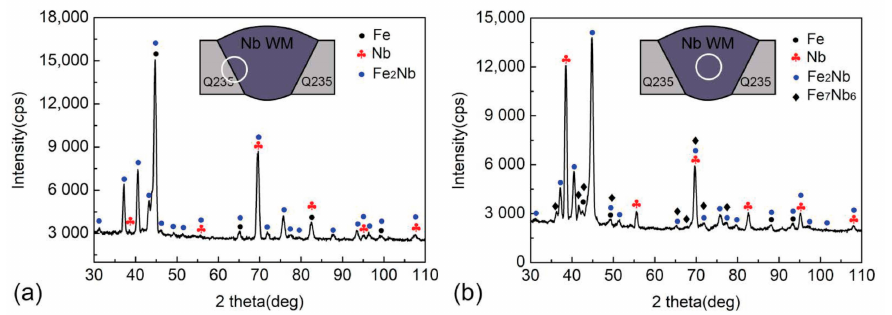
Figure 4. XRD patterns: ( a ) At Q235 BM/Nb WM interface; and ( b ) in the center of Nb weld metal.